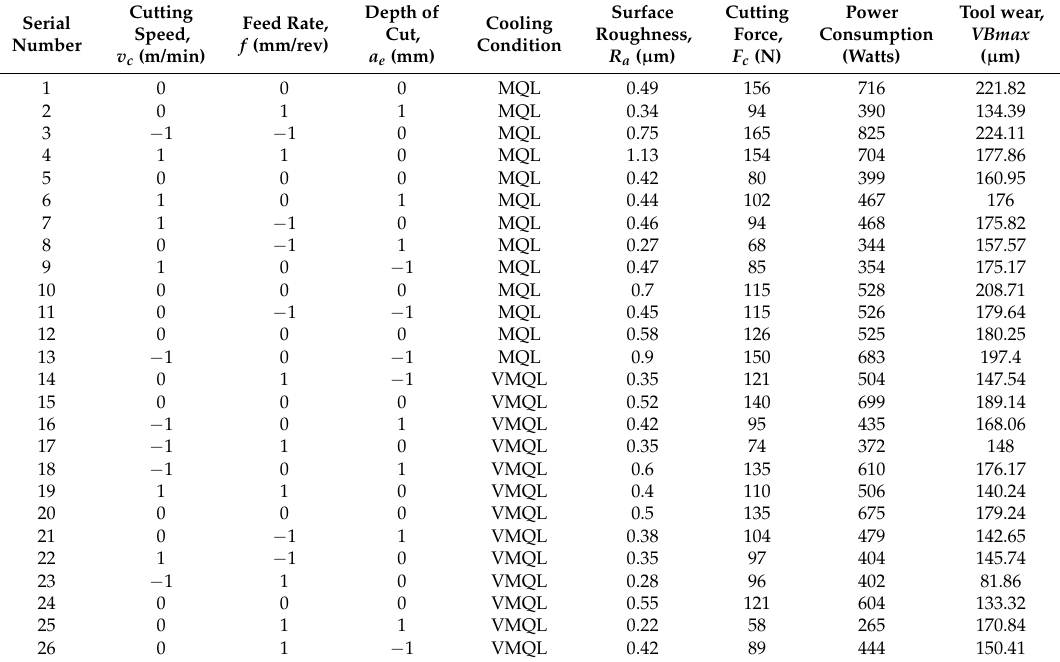
Experimental results [47]. MQL—minimum quantity lubrication; VMQL—vortex tube-assisted MQL.